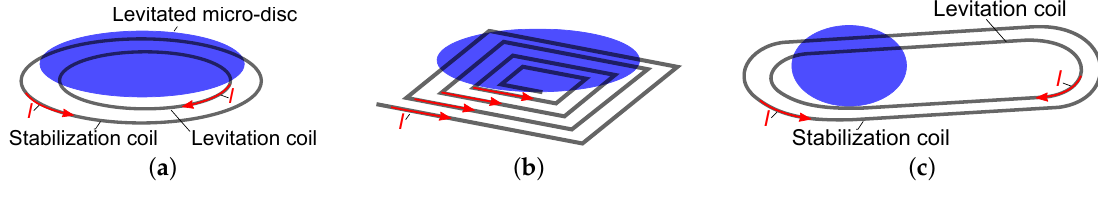
Figure 4. Inductive levitation micro-actuators: ( a ) two coils design, I is the electric alternate current (AC) [47]; ( b ) spiral coil design [52]; ( c ) two racetrack-shaped solenoidal 3D wire-bonded micro-coils